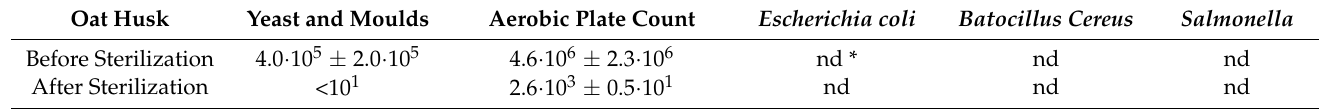
Table 1. Microorganisms (cfu · g − 1 ) identified in the OH before and after sterilization. Oat Husk Yeast and Moulds Aerobic Plate Count Before Sterilization After